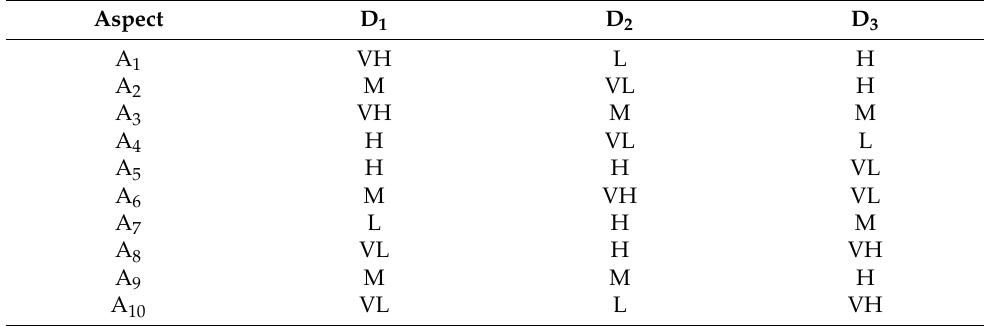
Table 7. Importance weights for each aspect.